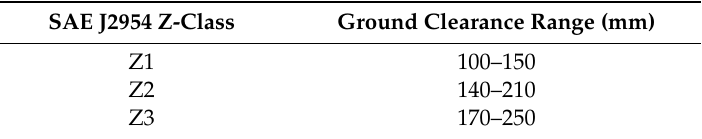
Table 2. SAE J2954 ground clearance ranges as per defined Z-Classes.